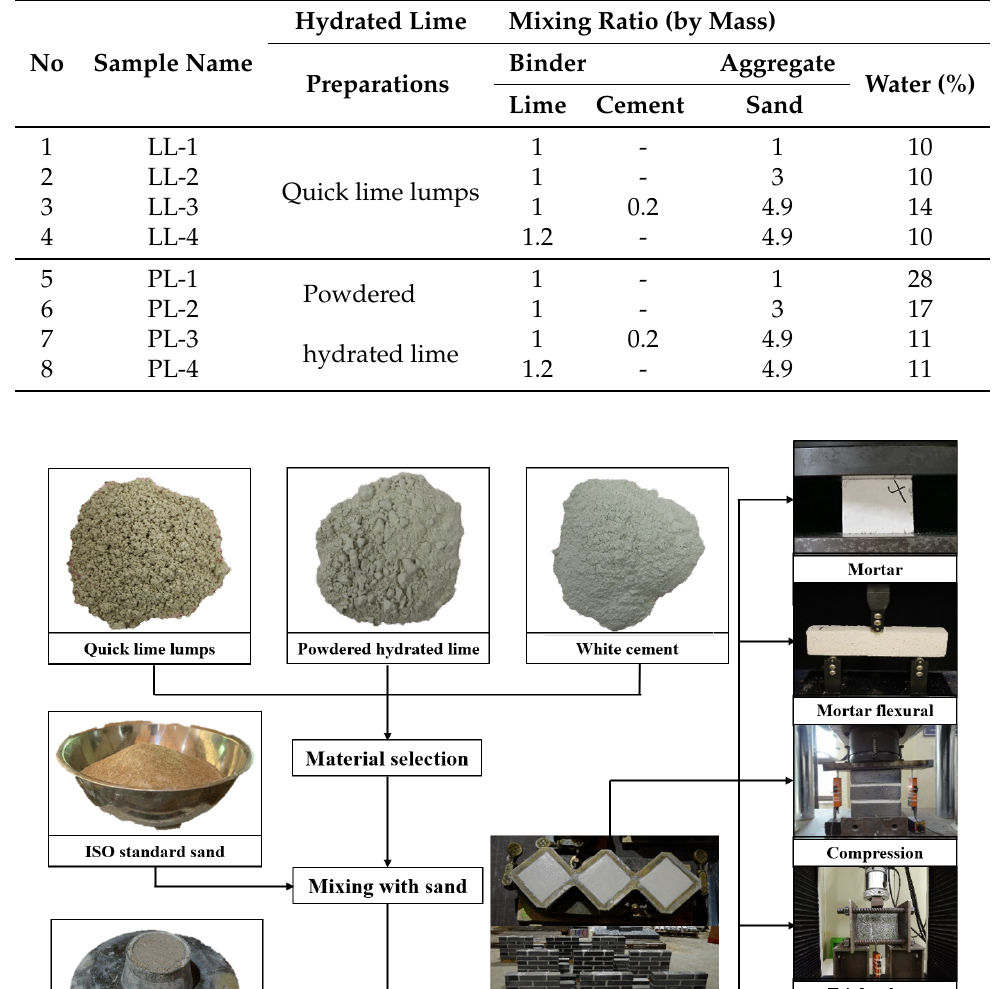
Table 2. Mixing proportions of lime mortar.